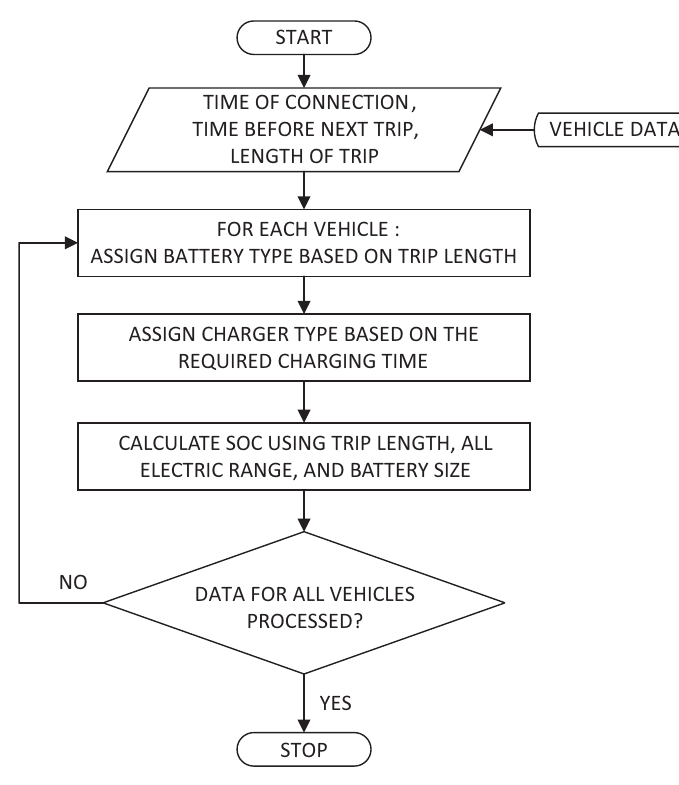
Figure 6. Vehicle assignment flow chart.